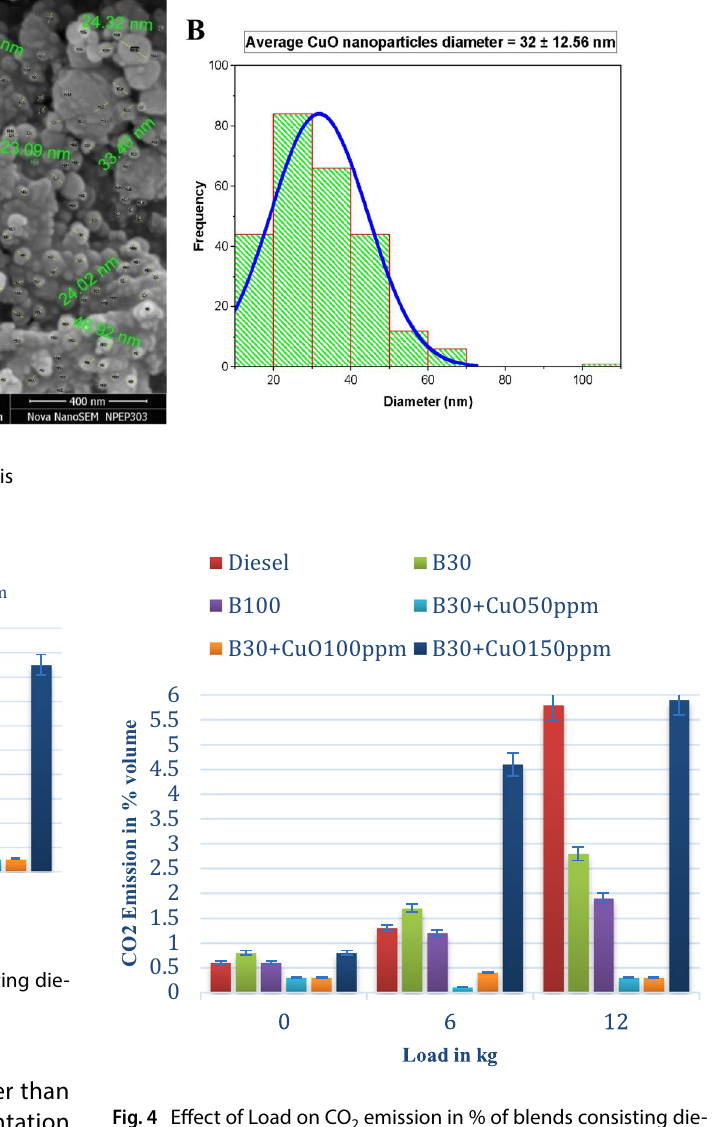
Fig. 4 Effect of Load on CO emission in % of blends consisting die- 2 sel and WCO biodiesel with CuO